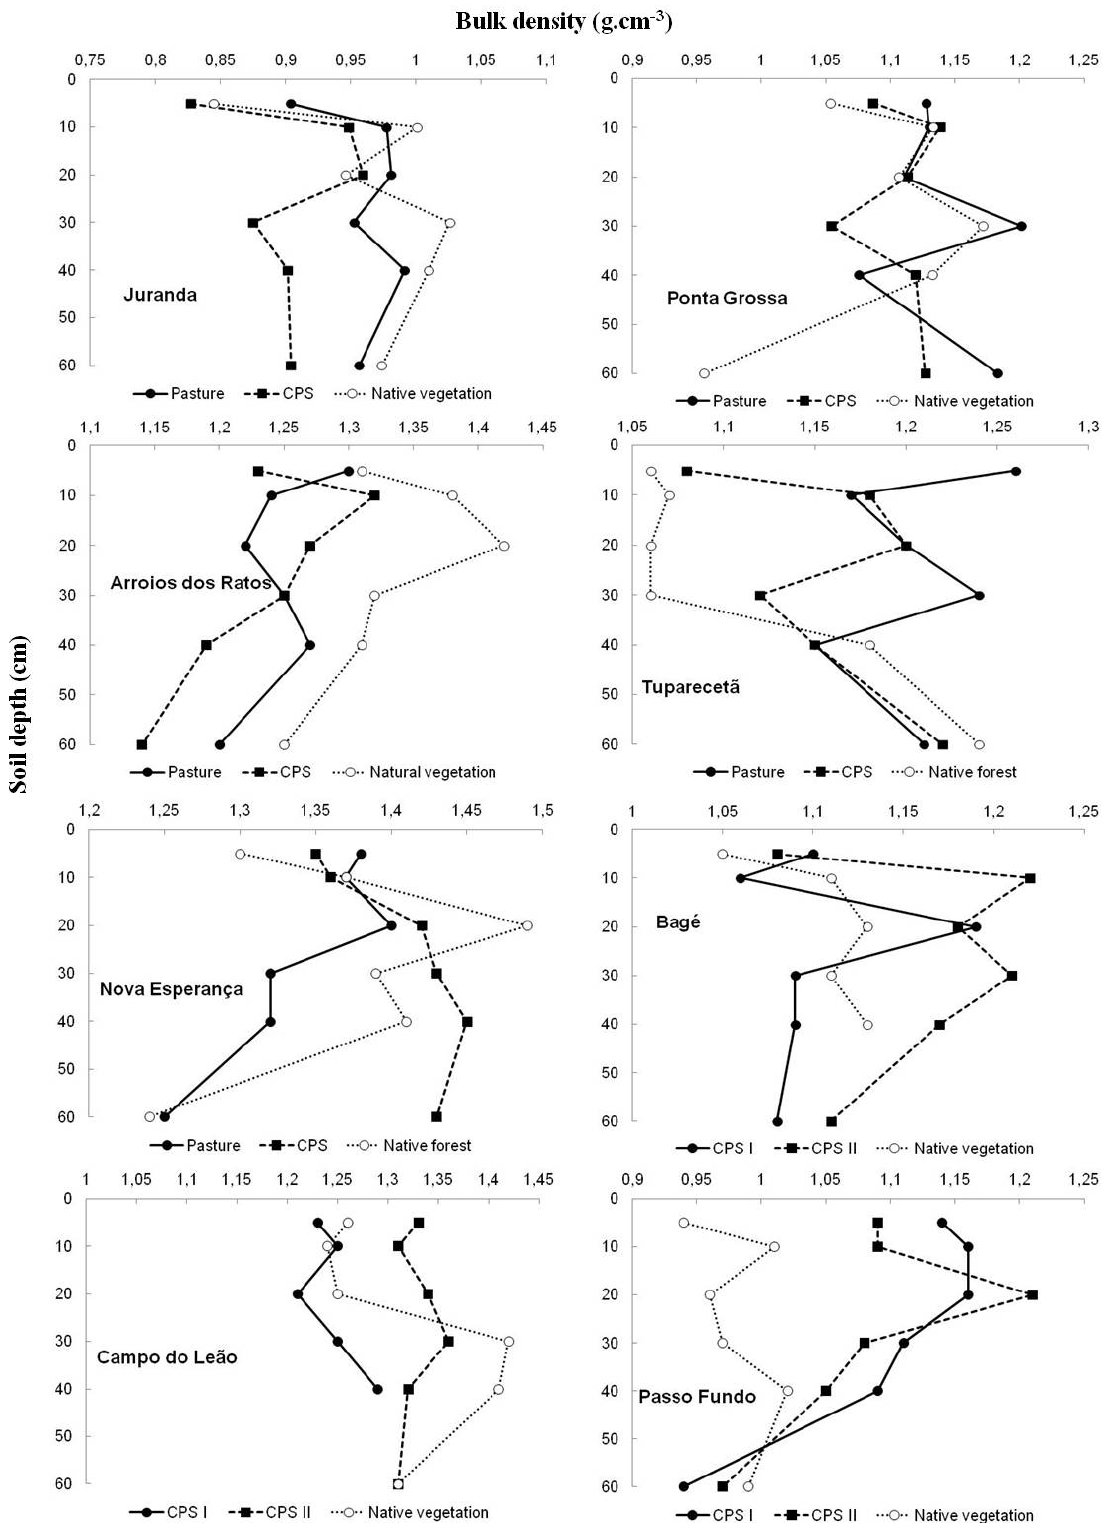
Fig. A1-cont. Fig. A1.